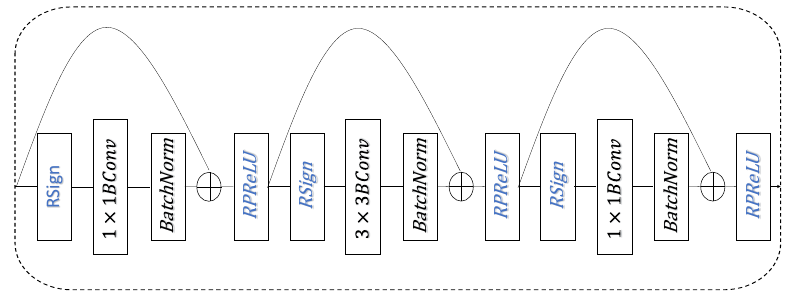
Figure 1. The block of ResNet, which combines RSign and RPReLU. BConv, binarized convolution.